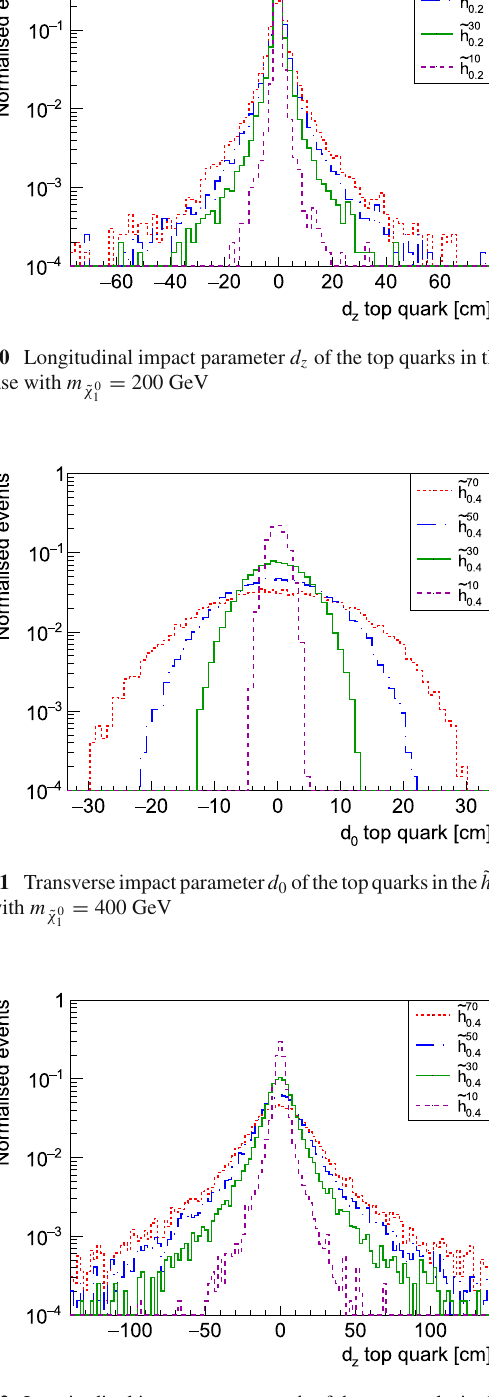
its interactions with the fermions and bosons in the